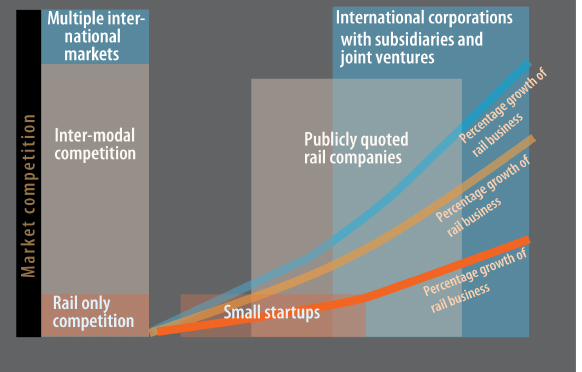
Figure 2. Entrepreneurial Expansion Trajectory in Rail Freight